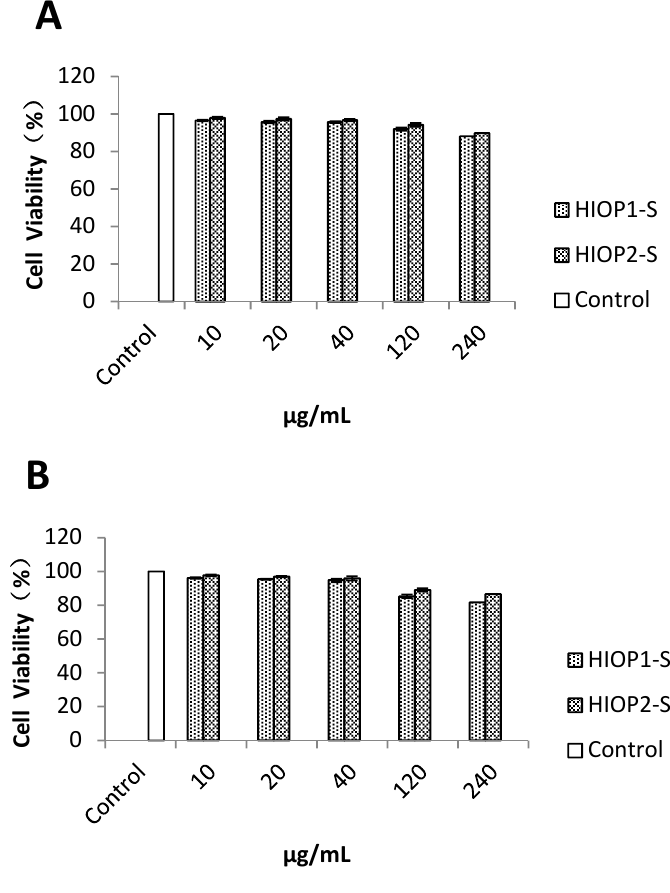
Figure 7. Evaluation of the cytotoxicity of HIOP1-S and HIOP2-S on HepG2 cells ( A ) at 48 h and ( B ) 72 h.